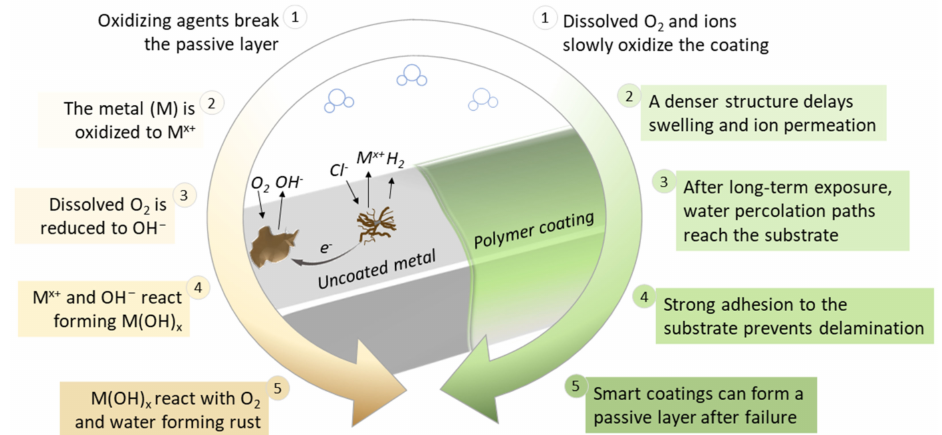
Figure 2. A representative cycle of metallic corrosion (left) and protection of typical polymeric coatings (right) immersed in aerated neutral saline solution [13,27,36].